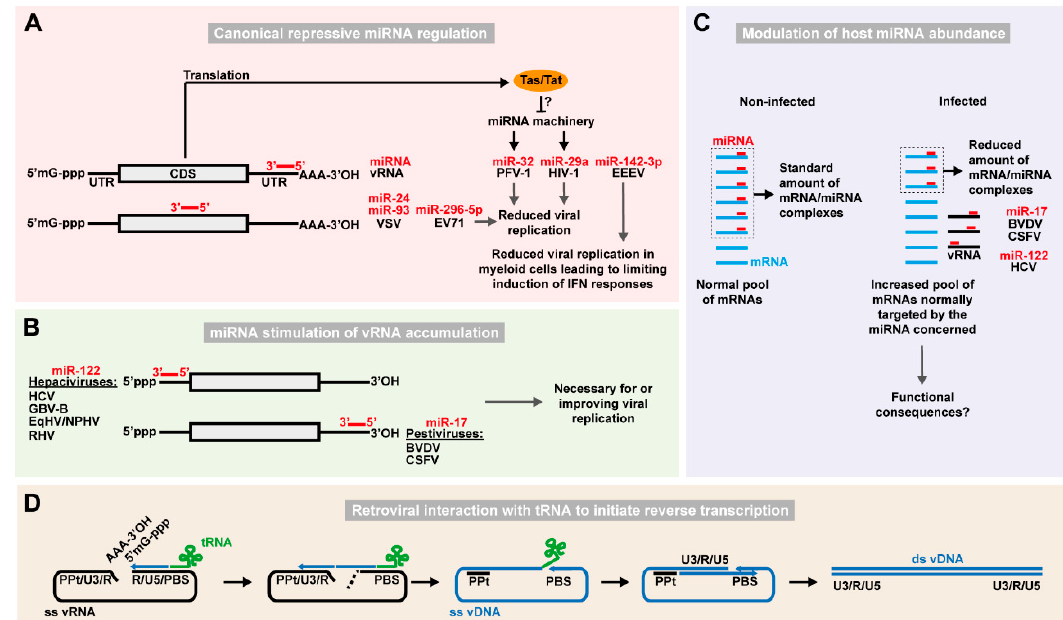
Figure 1. Function of host ncRNAs directly interacting with viral RNA. ( A ) Examples of repressive regulation of RNA virus replication via canonical miRNA-dependent targeting. Host miRNAs (red bars) targeting viral RNA (vRNA) CDS or 3 ′ UTR are shown. Capped 5 ′ -end (5 ′ mG-ppp) and poly-adenylated 3 ′ end (AAA-3 ′ OH) of the vRNA are also depicted. Viral proteins such as PFV-1 Tas or HIV-1 Tat may counteract the miRNA machinery. ( B ) Stimulation of RNA virus replication via miRNA-dependent targeting. Hepaciviruses and pestiviruses interact with miR-122 on the 5 ′ UTR and let-7 and miR-17 on the 3 ′ UTR, respectively, to stimulate IRES-driven translation, protection from degradation and replication leading to viral RNA accumulation. ( C ) Sponging of host miRNAs by viral RNA affects the expression of cellular mRNAs. In non-infected cells, a defined pool of miRNAs (red bars) targets the mRNA pool (light blue) for inhibition of translation or degradation. In infected cells, vRNA (black) can sponge a significant proportion of specific miRNA species resulting in a reduced available pool of that particular miRNA, and therefore a de-repression of normally targeted mRNAs. These effects have been described for the miRNA/vRNA combinations indicated. ( D ) Retroviral interaction with tRNAs to initiate reverse transcription of the viral RNA. In the Retroviridae family, a cellular tRNA (green) complementary to the primer binding site (PBS) sequence in the 5 ′ region of the viral (+)ssRNA (black) is used to initiate reverse transcription. The complementarity between the long terminal repeat sequences (including the unique 3 ′ [U3], repeat [R], and unique 5 ′ [U5] regions) at the ends of the vRNA assists in conversion of the viral genome into ssDNA (blue). Finally, synthesis of the second DNA strand is initiated from the polypurine tract (PPt) region that is resistant to RNAse H, degrading the remaining vRNA, to thereby generate the double-stranded vDNA (ds vDNA) that will get inserted into the cellular chromosome as a provirus.